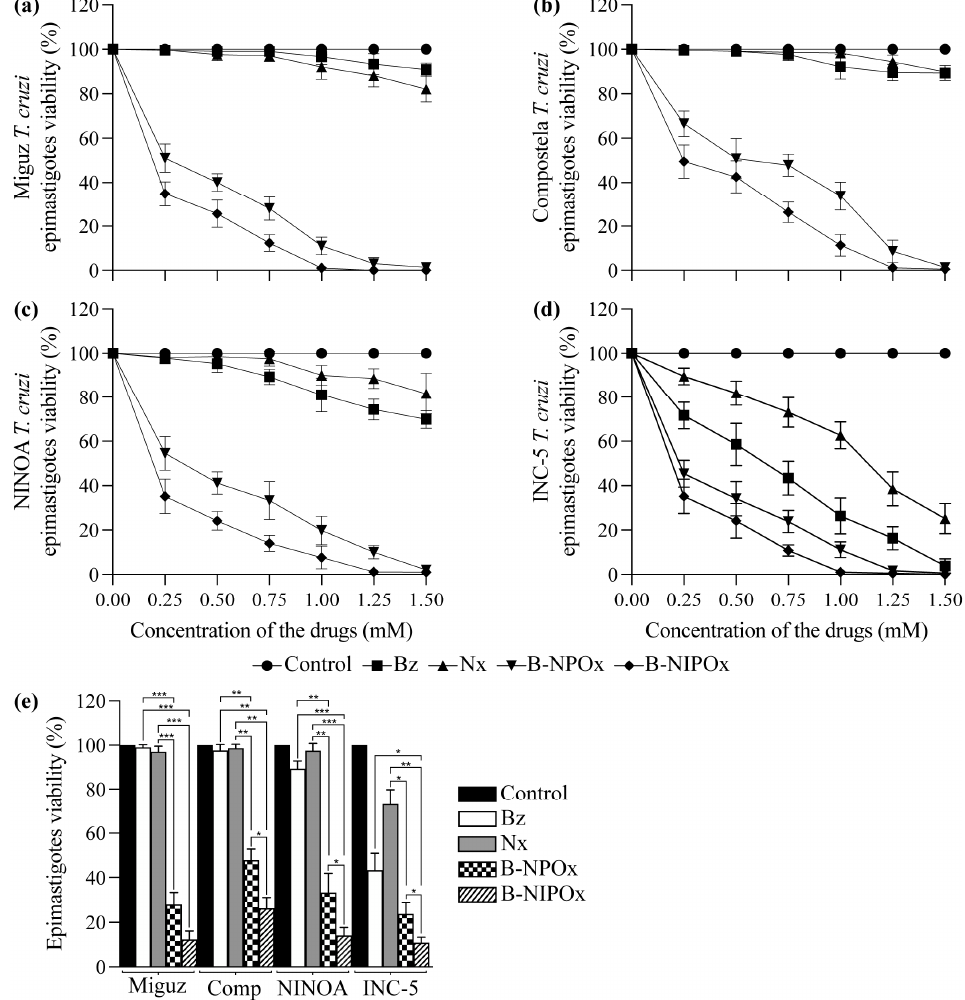
Figure 3. The benzyl ester of N-isopropyl oxamic acid (B-NIPOx) has a higher trypanocidal activity on epimastigotes than the benzyl ester of N-propyl oxamic acid (B-NPOx) and the reference drugs Benznidazole and Nifurtimox. The trypanocidal effect of B-NIPOx was evaluated on epimastigotes of the ( a ) Miguz, ( b ) Compostela (Comp), ( c ) NINOA and ( d ) INC-5 T. cruzi strains and compared with the drugs B-NPOx, Benznidazole (Bz) and Nifurtimox (Nx). The drugs were dissolved in 1% DMSO and were evaluated at concentrations of 0.25, 0.50, 0.75, 1.00, 1.25 and 1.50 mM for 60 min at 28ºC in cultures with 1 × 10 6 epimastigotes/mL. The viability of the epimastigotes was determined by the alamarBlue method; the control, which was set to 100%, represents the viability of the parasites in 1% DMSO. ( e ) Asterisks represent statistically significant differences between the viability of the epimastigotes T. cruzi strains treated with 0.75 mM drugs (* p ≤ 0.05, ** p ≤ 0.01 and *** p ≤ 0.001). n = 6. One experiment representative of three is shown.